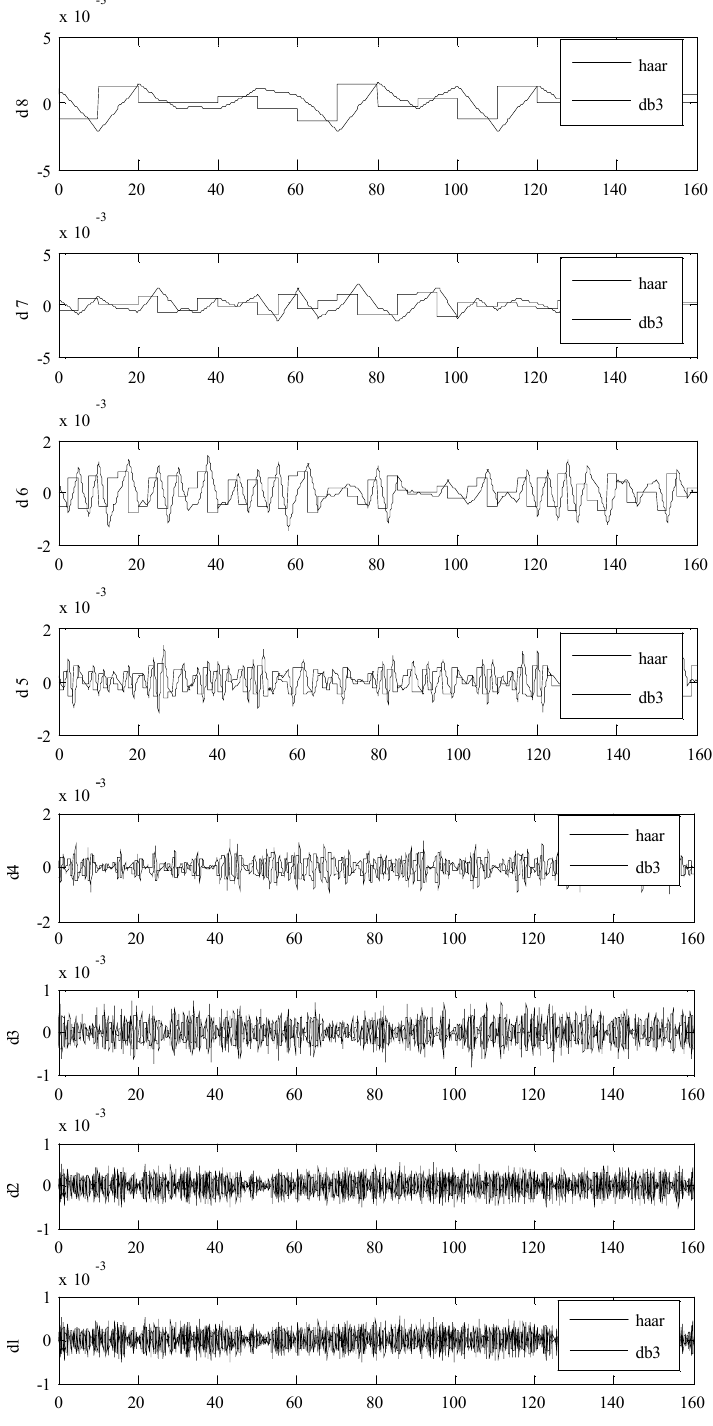
Fig. 13. Signal of different frequency band in synthesis